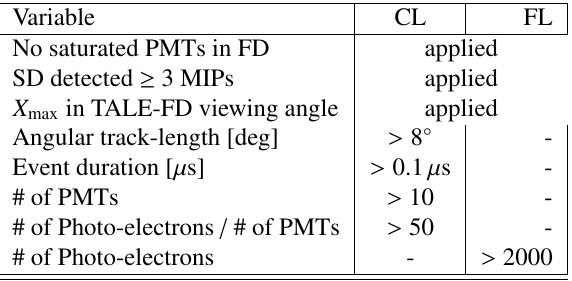
Table 1: quality cuts applied in this study.